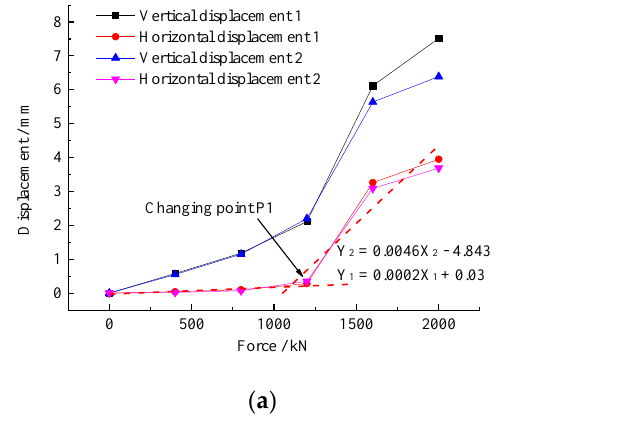
Table 2. Calculation results of the rotating system. Parameters